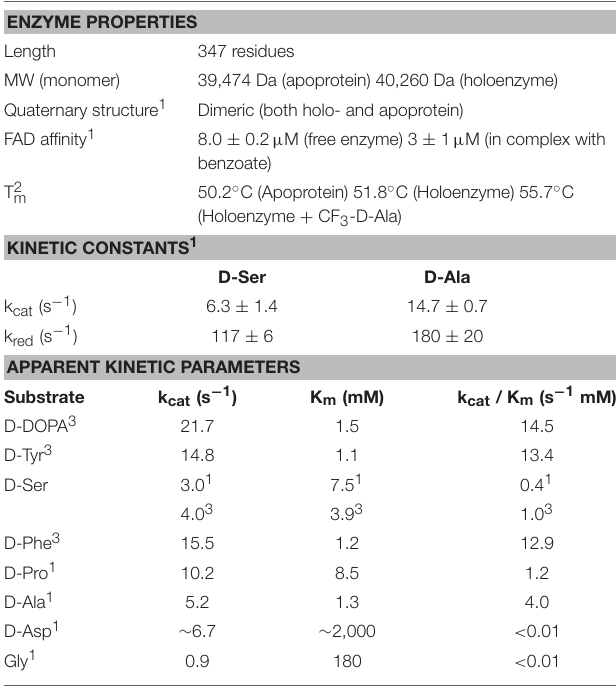
TABLE 2 | Main functional and structural properties of human D-amino acid